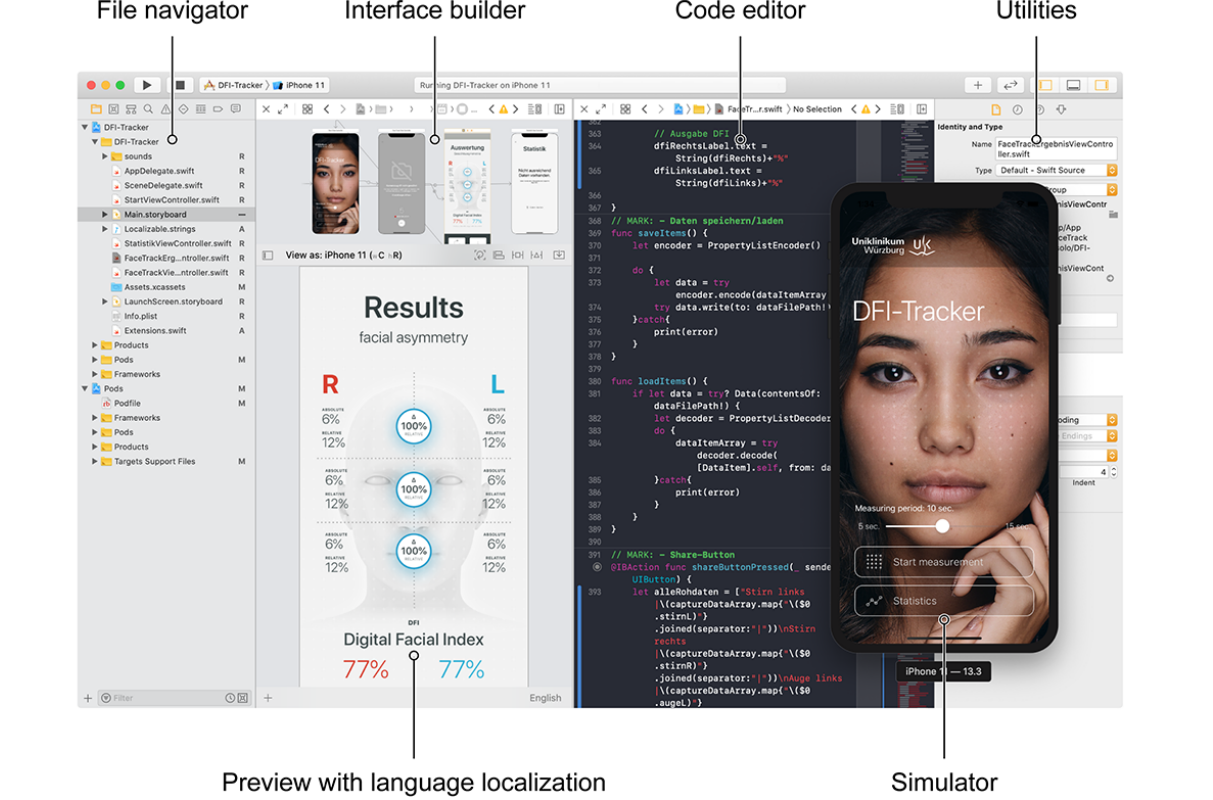
Figure 2. Screenshot of the app developed in the Apple Xcode Development environment. All associated project files are listed in the file navigator. The graphical user interface is designed with the interface builder and then linked to the code, which is written in the code editor. A utility area allows further settings. For the implementation of different regions, the user interface can be checked via the preview in the corresponding language. The simulator enables testing of the app on various virtual devices with the iOS operating